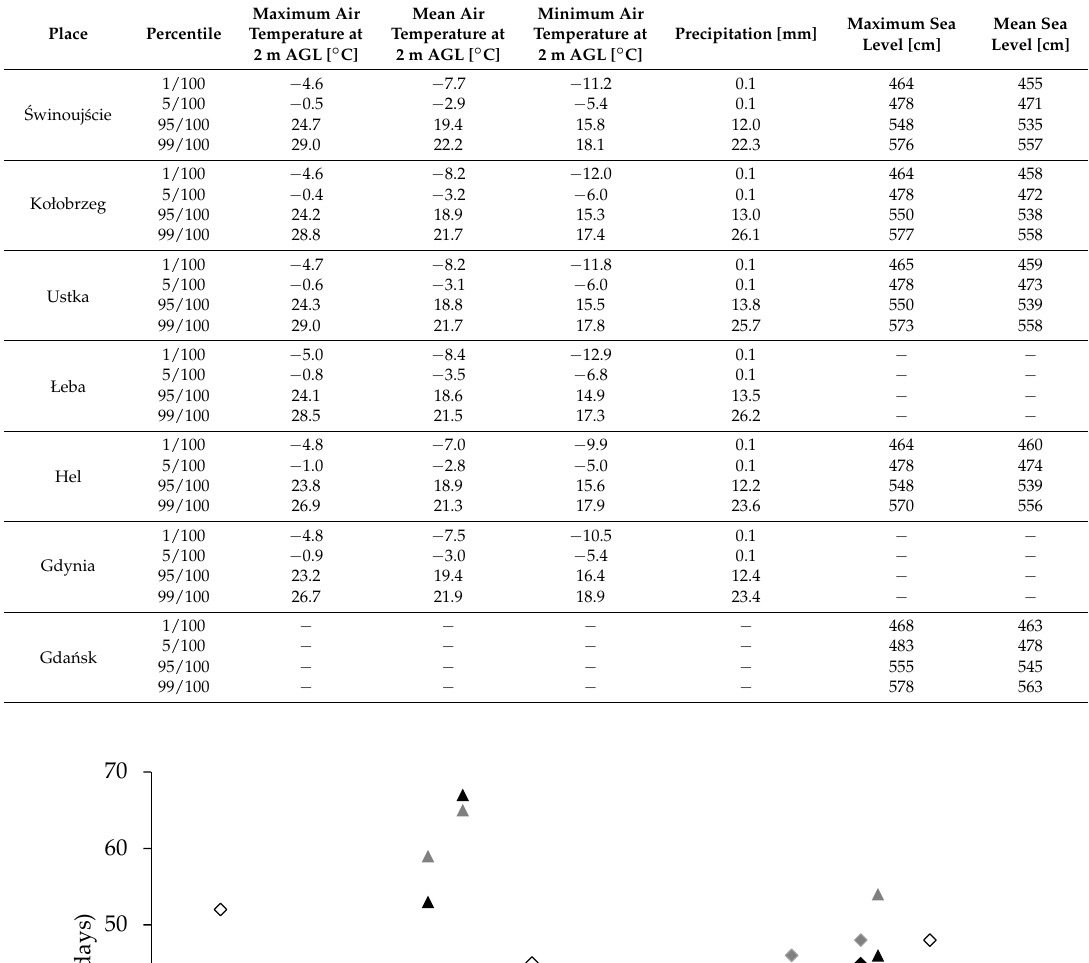
Table 4. Extreme threshold values (percentiles 5/100 and 95/100) and exceptionally extreme threshold values (percentiles 1/100 and 99/100) of hydrometeorological events in the Polish coastal zone of the South Baltic (1965–2014).